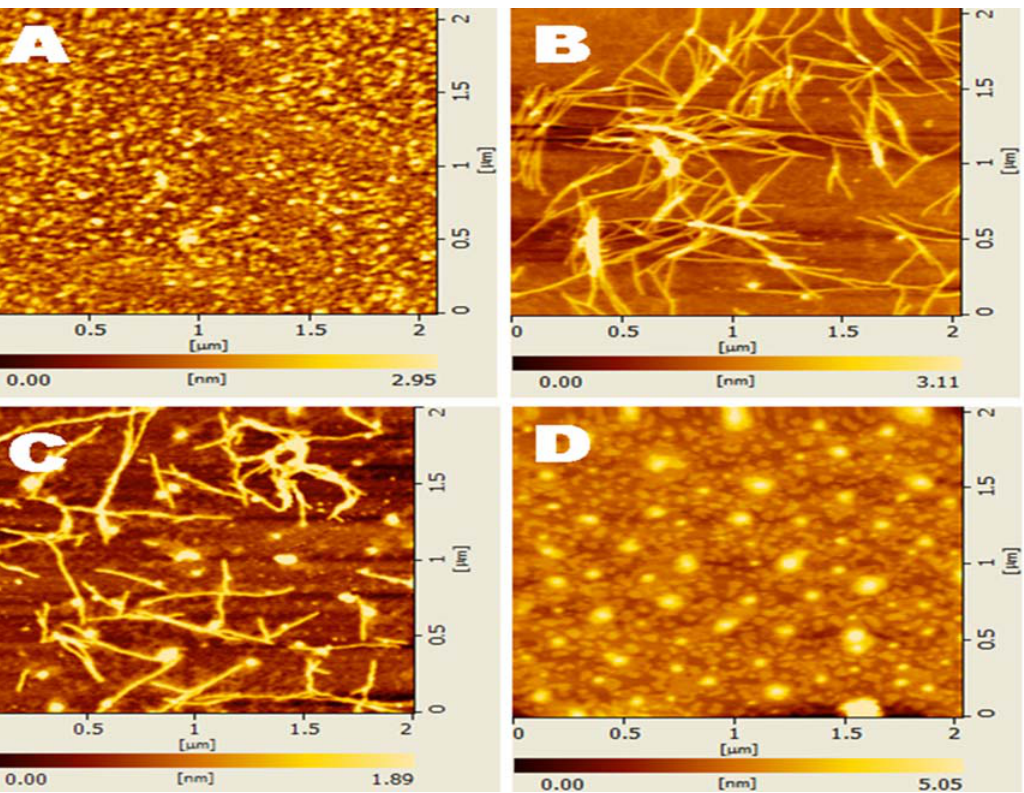
Figure 10. pH sensitivity. The AFM images of d-EAK16 (100 m M) are displayed under different pH conditions. A) pH1, B) pH7, C) pH10.6, D) pH12.8. When at pH1 or pH12.8, the peptides aggregated to form the globular structure, when at pH10.6 globular and nanofibers were formed; but at pH7, nanofibers were observed.